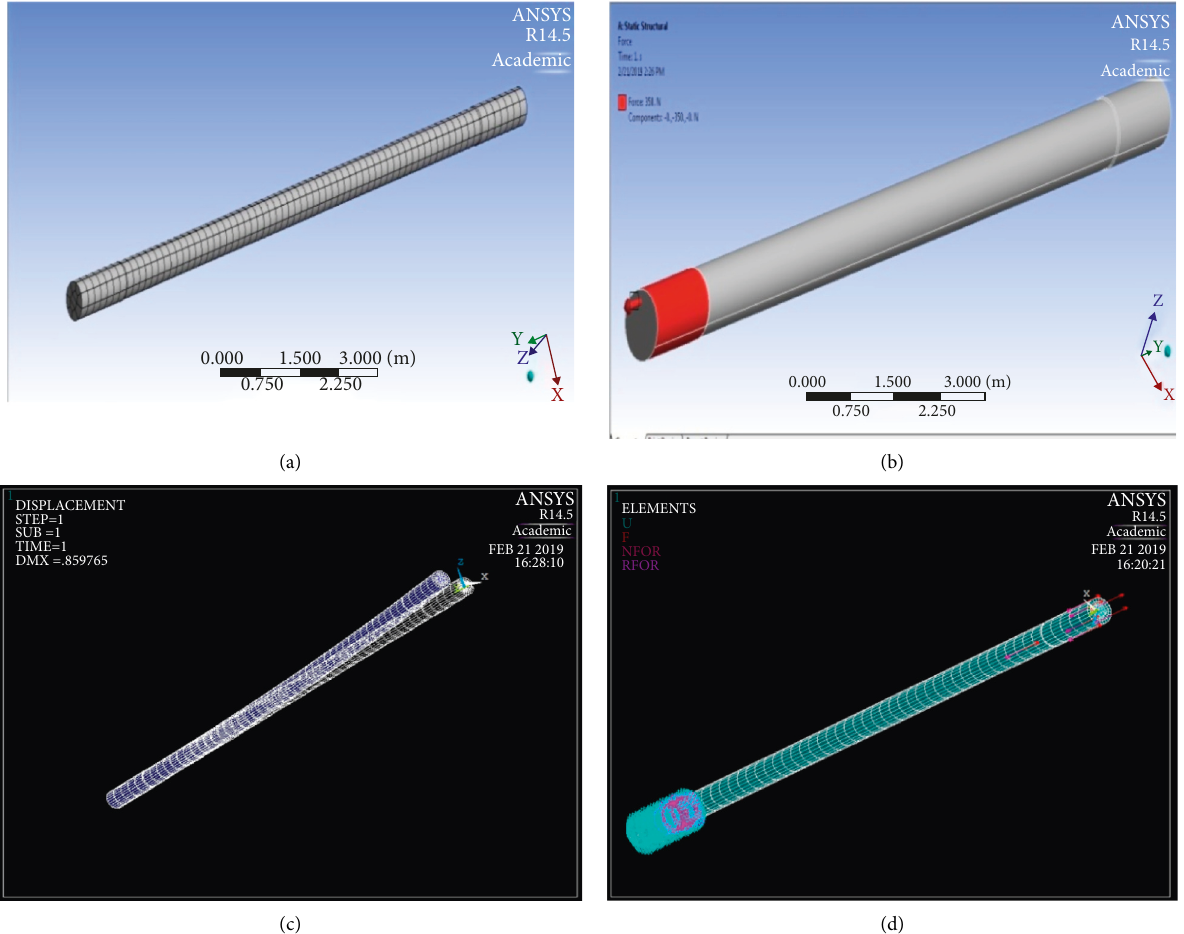
Figure 7: (a) (c) Mesh generation of cylindrical specimen in ANSYS and Deform 3D. (b) (d) Displacement function and boundary conditions in ANSYS and Deform